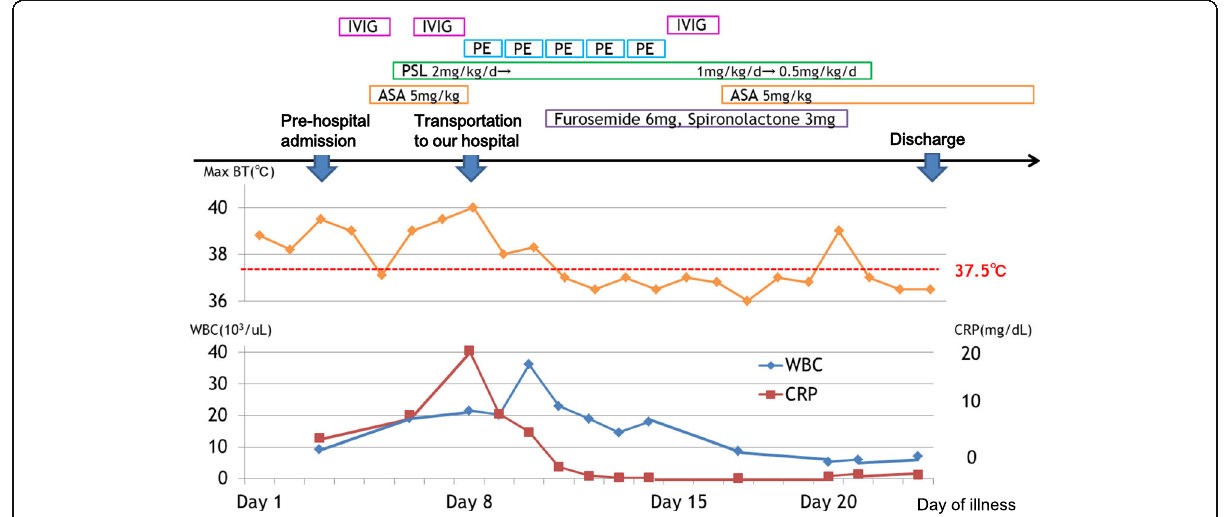
Fig. 2 Progress course of case no.4. After PE, both inflammatory data and body temperature decreased